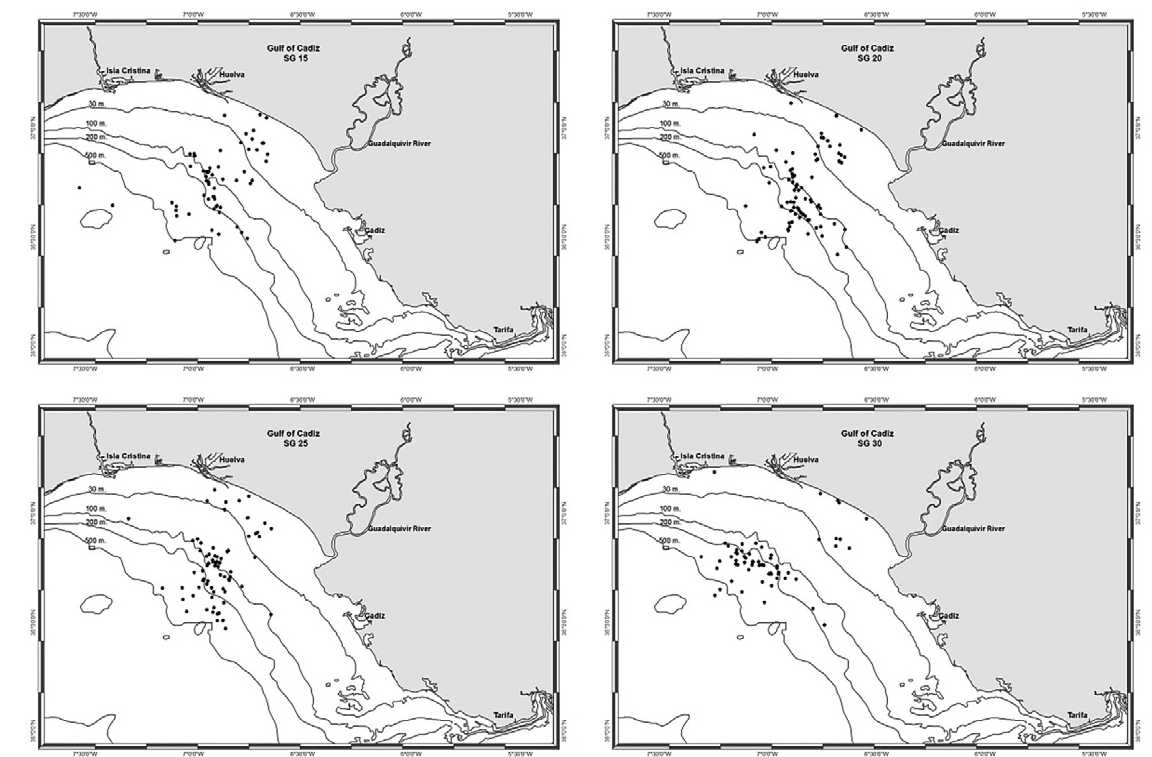
Fig. 1 . – Spacial distribution of the sampling by sorting grid in the Gulf of